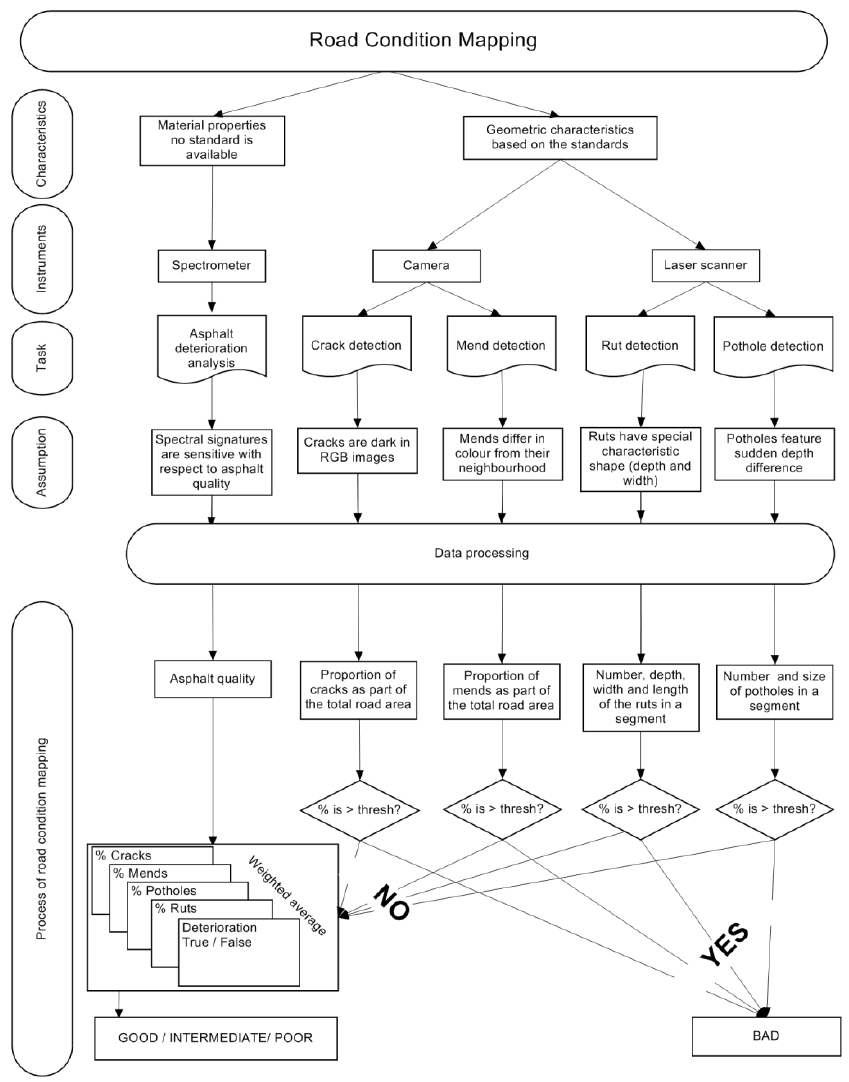
Figure 3. The overall assessment scheme